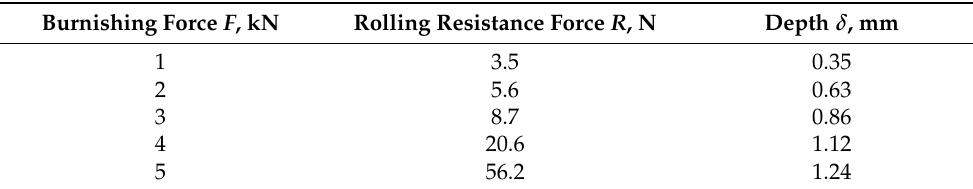
Figure 9a enlarged the contact area in the deformed zone of adjacent rings. Figure 9b shows a schematic diagram of deformations on the surfaces of the rings after their discon- nection. The measurements of the layer thickness δ made during burnishing of the roller with different pressure force values are listed in Table 4. Table 4. The results showing the depth of the plastically deformed layer δ for the various burnish- ing forces.